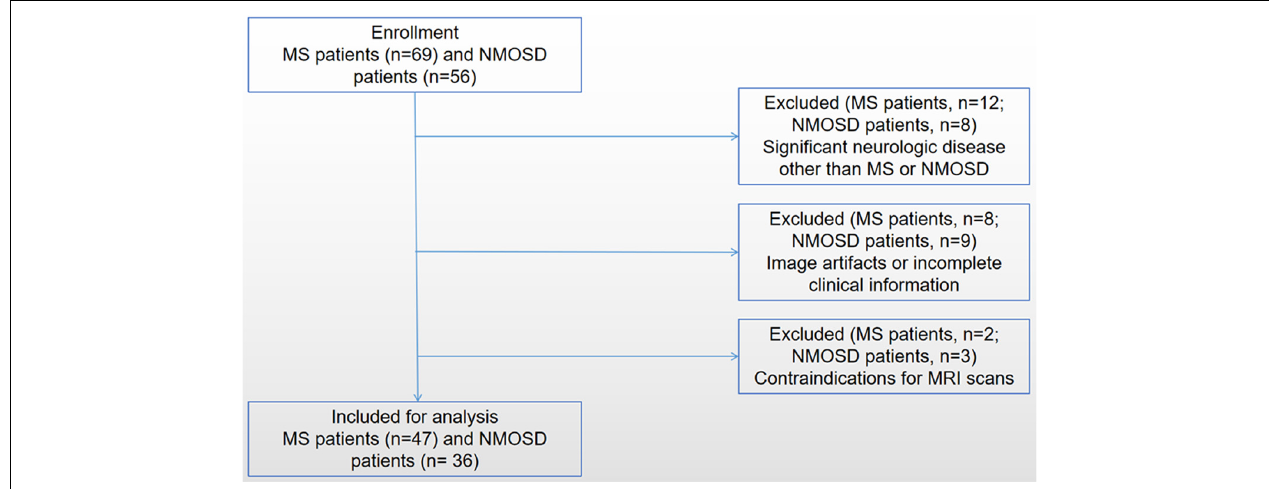
FIGURE 1 | The flowchart shows the enrollment of MS and NMOSD patients.